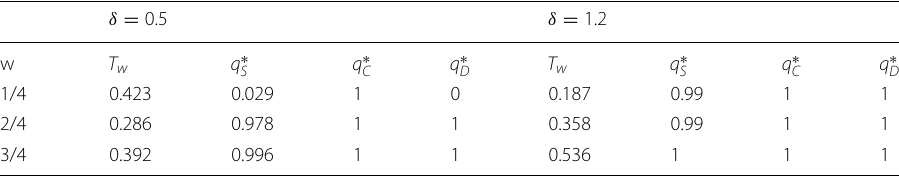
, q ∗ , q ∗ Table 4 The values of q ∗ for which the weighted sum throughput is maximized and the S C D queue at S is stable for α = 0.7, M U = 200, M D = 1000, and M S = 2000 δ = 0.5 δ = 1.2